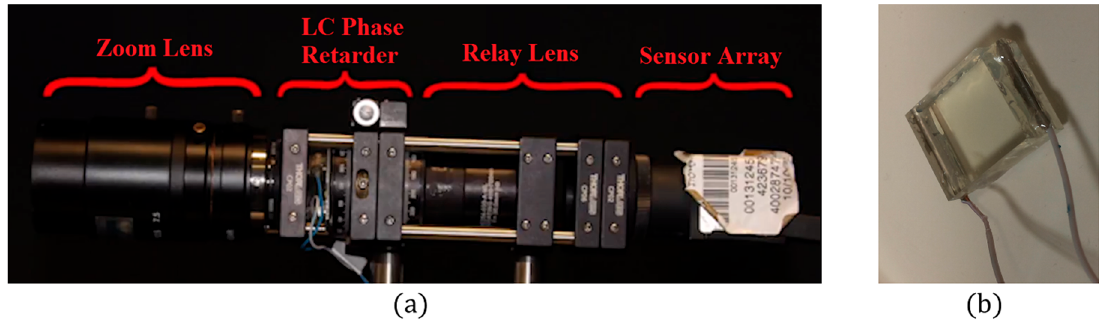
Figure 5. ( a ) Realization of the CS-MUSI camera. ( b ) In-house manufactured LC cell.